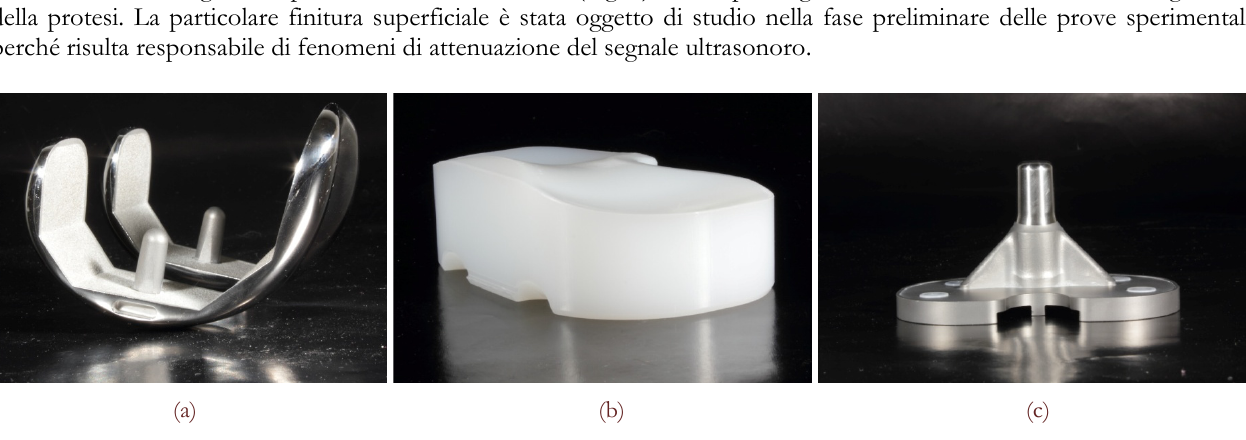
Figura 1: Protesi totale di ginocchio: a) componente femorale, b) inserto in UHMWPE, c) componente tibiale. Figure 1: Knee prosthesis: a) femoral component, b) UHMWPE insert, c) tibial component.